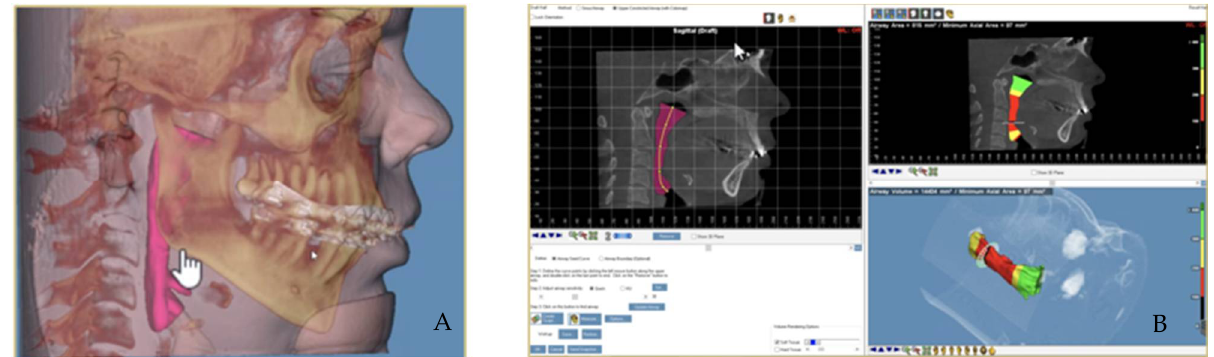
Figure 2. Airway measurement with CBCT: anatomic boundaries of the upper pharyngeal airway (pink) ( A ). Segmentation of the upper airways: nasopharynx (green), oropharynx (red) and hypopharynx (lower yellow) ( B ).